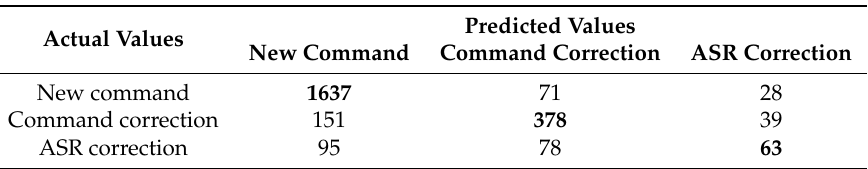
Table 2. Confusion matrix of SAIF test